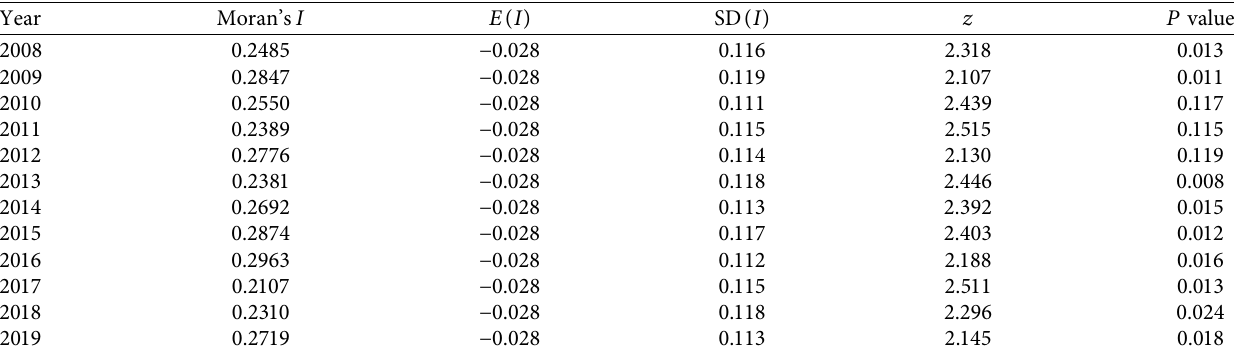
Table 4: Global Moran’s I statistical indicators of the ecological environment in 31 provinces of China from 2008 to